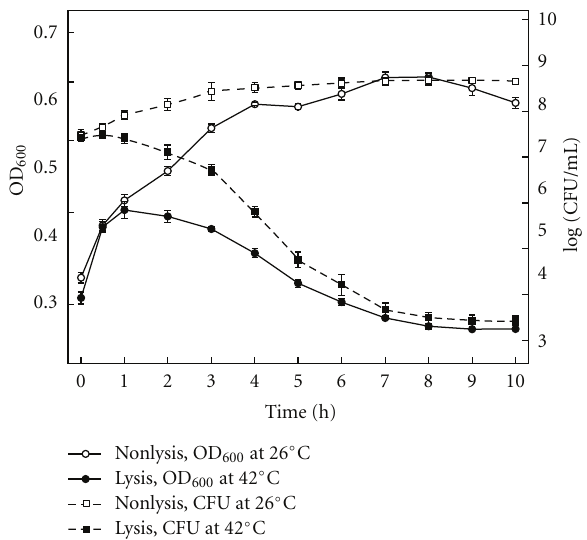
Figure 2: Growth and lysis kinetics of F. columnare G4cpN22 harboring plasmid pBV E cat by temperature induction of gene E expression. At time zero, the growth temperature of three bottles of the cultures was shifted from 26 ◦ C to 42 ◦ C (filled symbols), whereas the others served as noninduced control at 26 ◦ C (open symbols). Growth and lysis were monitored by the measurement of the OD 600 (open circles and filled circles) and the determination of the number of CFU (open squares and filled squares and discontinuous